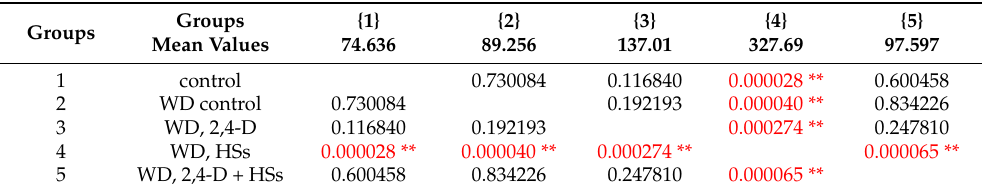
Table 10. ANOVA test for shoot cytokinins content followed by Duncan test. Values in the cells correspond to p for the difference between the mean values; p ≤ 0.05 is marked with *; p ≤ 0.01—with ** for control plants untreated with either bacteria or HSs and plants grown under water deficit (WD): control, plants treated with Pseudomonas plecoglossicida 2,4-D (2,4-D), humic substances (HSs) and their combinations (2,4-D + HSs).